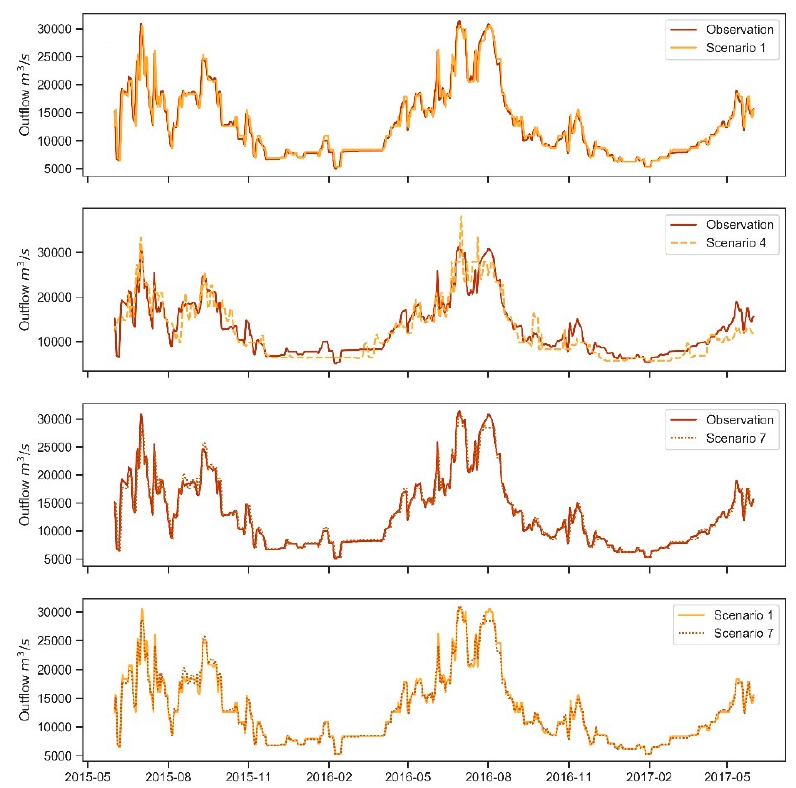
Figure 5. Comparison of observed and simulated reservoir outflows.